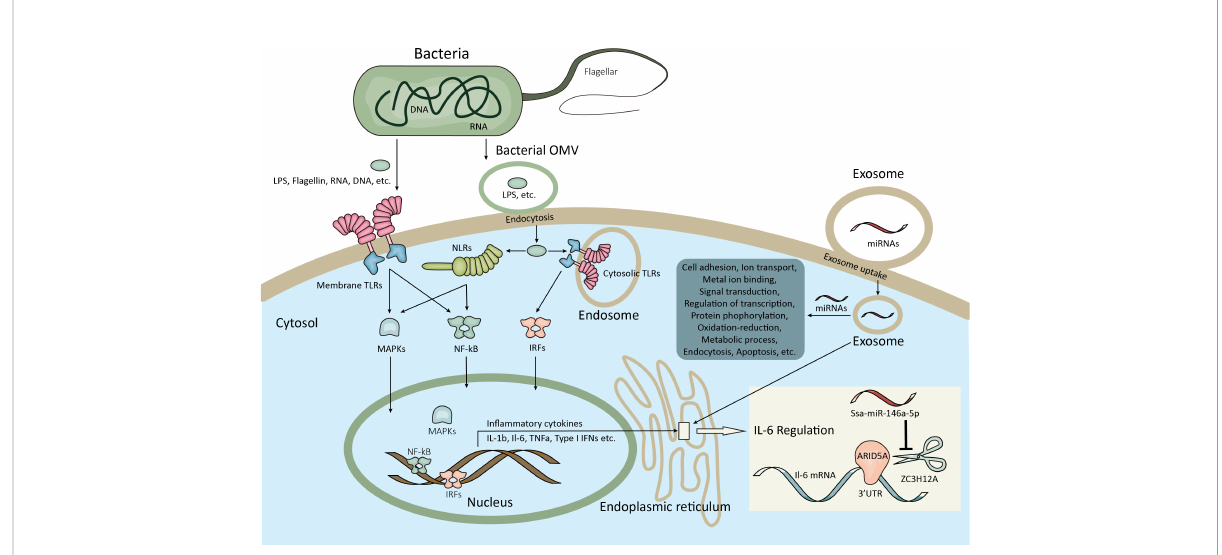
FIGURE 7 Schematic illustration of the in fl ammatory and immune responses potentially regulated by exosomal miRNAs in the present study. The bacterial virulence factors such as fl agellar, proteases, etc. facilitate the adhesion and invasion of bacteria to the host cell. Meanwhile, the bacterial virulence factors including fl agellin, RNA, DNA, LPS, etc. are recognized by the host membrane PRRs (e.g. TLRs) or transported by bacterial OMVs into the host cytosol by endocytosis and then recognized by cytosolic PRRs (e.g. TLRs, NLRs). After pathogen recognition, signaling pathways involved in the regulation of in fl ammatory and immune responses were activated at both transcriptional and posttranscriptional levels (e.g. NF- k B, IRFs, MAPK), resulting the homeostasis of cytokine production. Moreover, the bacteria are able to compete for metal ions and affect the metabolic process of the host cell. The above-mentioned processes are potentially regulated by exosomal miRNAs after exosome uptake by endocytosis or other ways. For example, ZC3H12A can degrade IL-6 mRNA by binding to its 3 ’ UTR on ER, which are counteracted by ARID5A, while the ZC3H12A mRNA could be inhibited by ssa-miR-146a-5p from the exosomes which have access to the ER. LPS, Lipopolysaccharide; PRRs, Pattern recognition receptors; TLRs, Toll-like receptors; OMVs, Outer membrane vesicles; NLRs, Domain-like receptors; NF- k B, Nuclear factor − k B; IRFs, Interferon-regulatory factors; MAPK, Mitogen-activated protein kinase; IL-6, Interleukin-6; 3 ’ UTR, 3 ’ Untranslated region; ER, Endoplasmic